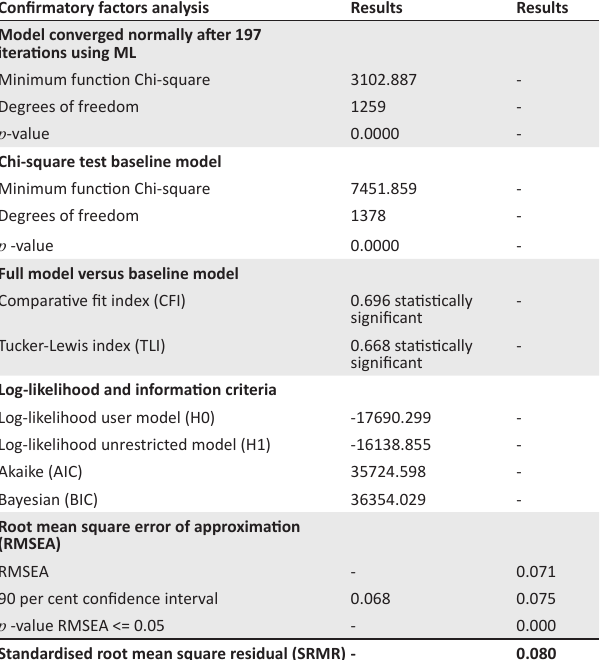
TABLE 8: Test statistics for the confirmatory factor analysis (CFA) report.